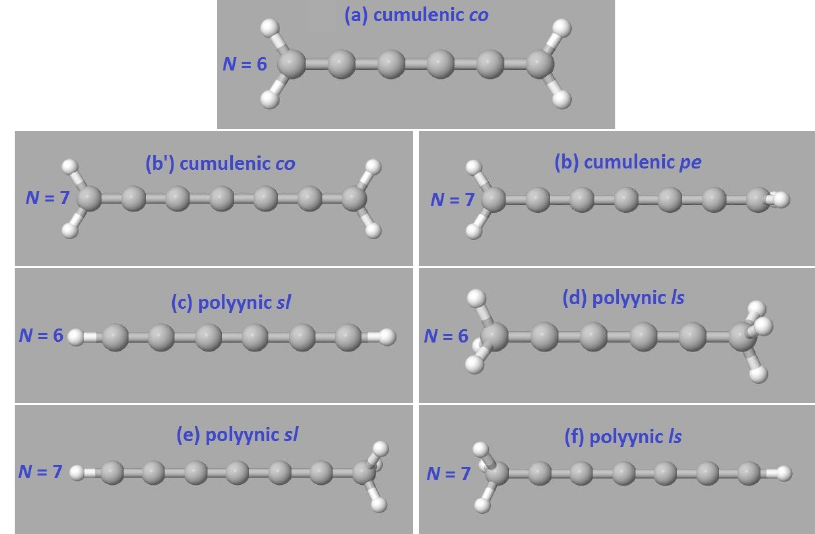
Figure 1. Illustration of cumulenic and polyynic carbynes. By co ( pe ) we denote a molecule with coplanar (perpendicular) methylene groups and by sl ( ls ) we denote a molecule with short-long-... (long-short-...) sequence of bonds. ( a ) N = 6 cumulenic co , ( b ’) N = 7 cumulenic co , ( b ) N = 7 cumulenic pe , ( c ) N = 6 polyynic sl , ( d ) N = 6 polyynic ls , ( e ) N = 7 polyynic sl , and ( f ) N = 7 polyynic ls . To study charge transfer, we place a hole initially at the first site, which is made of the first carbon and one or two or three hydrogens. Then, we follow its temporal and spatial evolution. In a simple picture, the first and the last carbons have in ( a ), ( b ’), ( b ) sp 2 , in ( c ) sp , in ( d ) sp 3 , in ( e ) sp and sp 3 , and in ( f ) sp 3 and sp